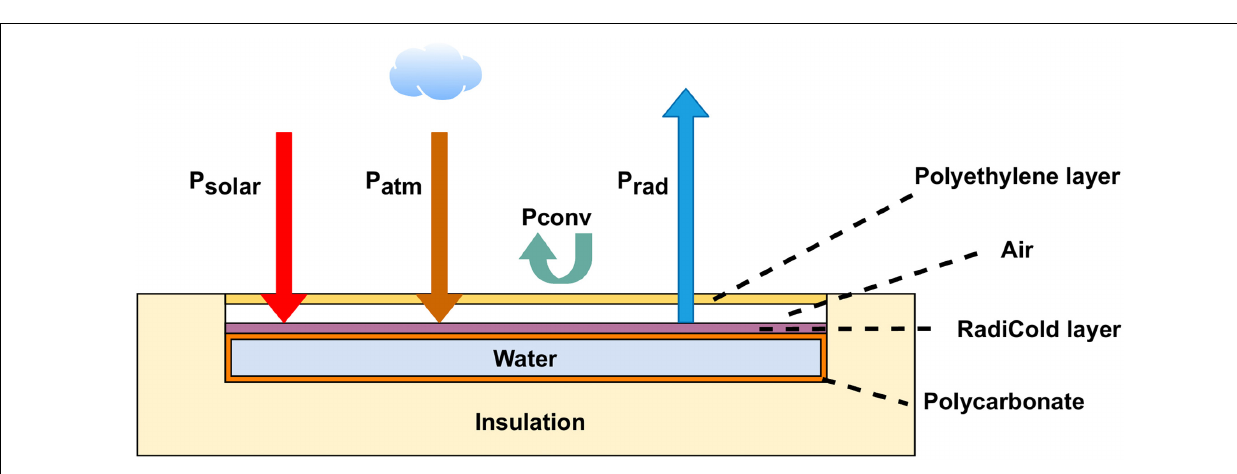
FIGURE 3 | Components of the radiative cooling system with heat